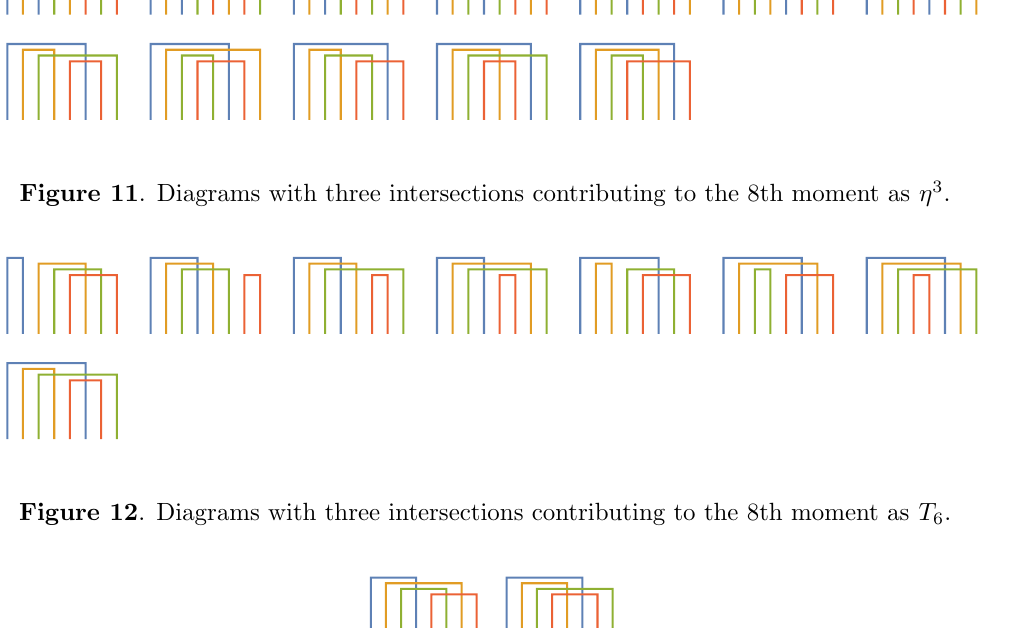
Figure 13 . Diagrams with four intersections contributing to the 8th moment as T 44